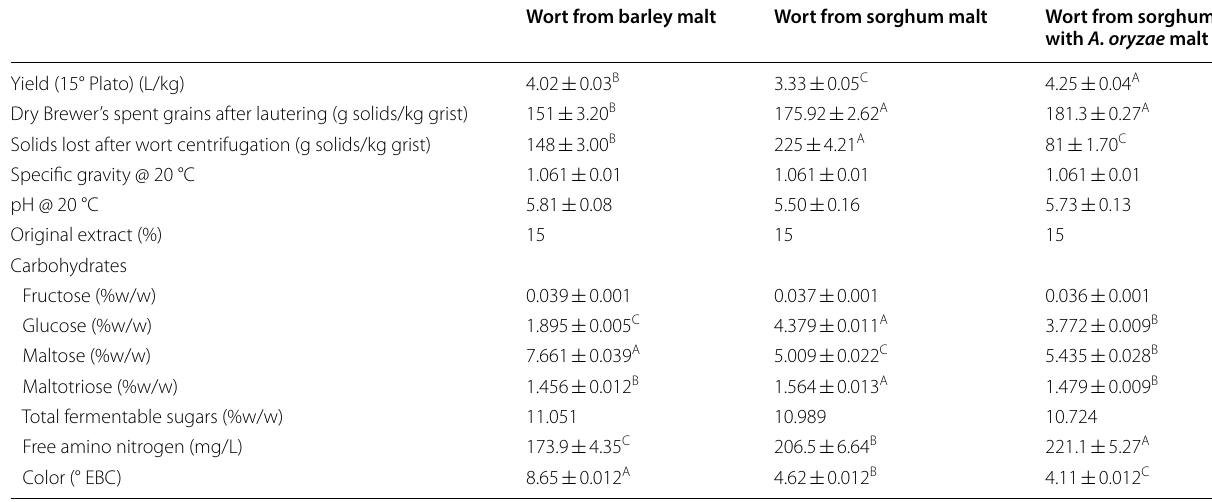
Mean comparisons with different letter(s) within rows are statistically different ( P < 0.05)